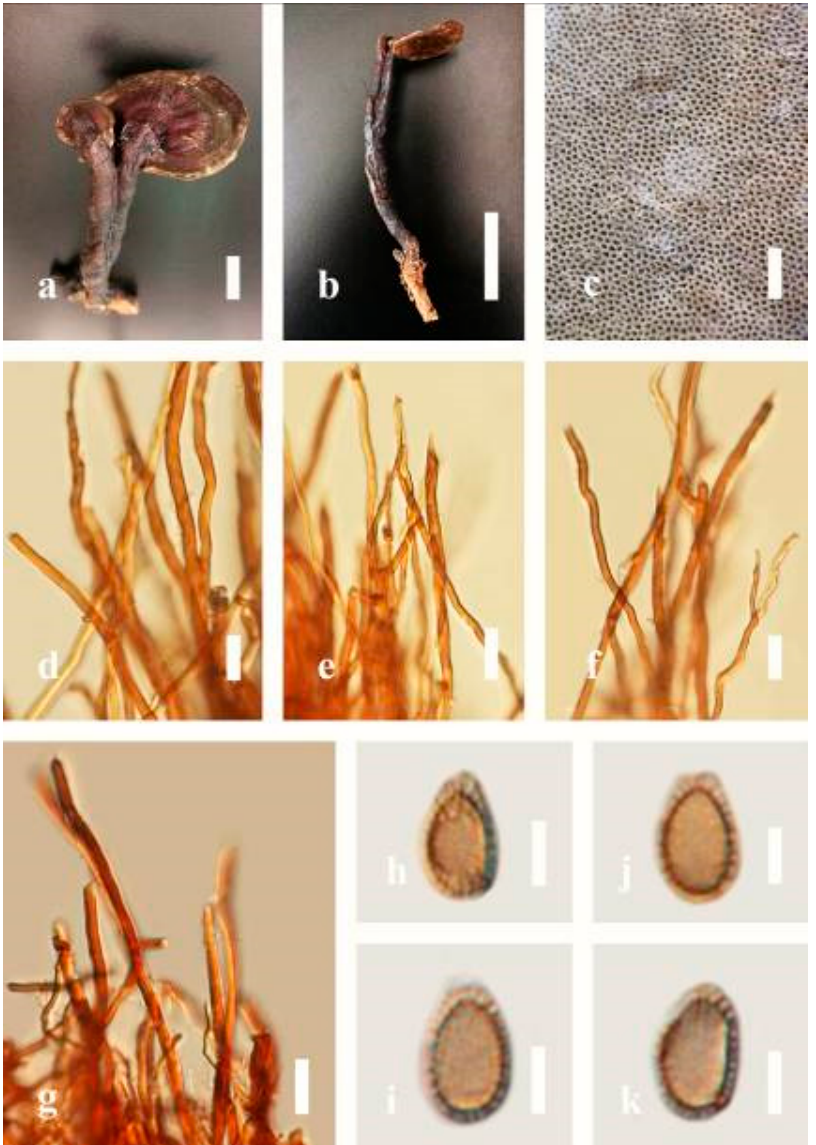
Figure 6. Morphology of Ganoderma calidophilum (MFLU 19 ‐ 2174): ( a , b ) mature basidiomes; ( c ) pore characteristics; ( d – f ) context hyphae in Melzer’s reagent; ( g ) tube layer hyphae in Melzer’s reagent; ( h – k ) basidiospores. Scale bars: ( a ) = 2 cm, ( b ) = 5 cm, ( c ) = 1000 μ m, ( d – g ) = 20 μ m, ( h – k ) = 5 μ m.